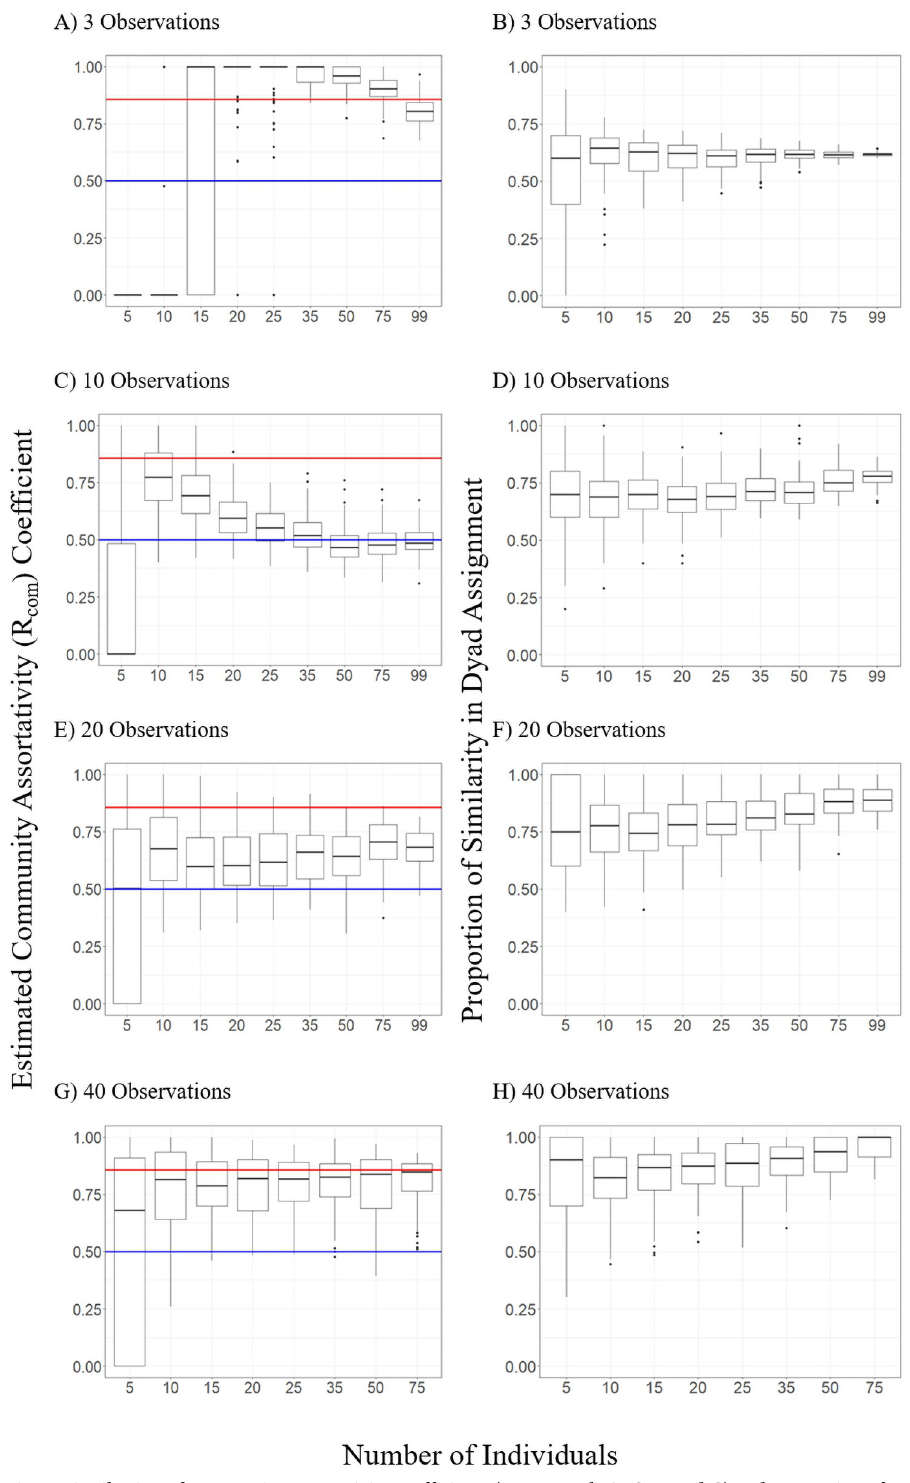
Fig 4. Distribution of community assortativity coefficients (R com ; panels A, C, E, and G) and proportion of correctly assigned dyads (panels B, D, F, and H) as a factor of the number of individuals and the number of observations per individual included in the network. Boxes represent the 25 th to 75 th percentile of values with the center line representing the median value. In panels A, C, E, and G, the blue line indicates the suggested